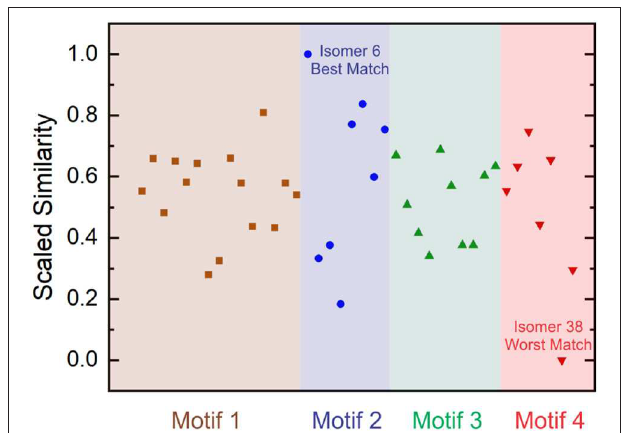
FIGURE 6 | Scaled Euclidean similarities of computed harmonic vibrational spectra to experimental IRMPD spectra for the protonated serine dimer. Isomer 6 gives the best match and Isomer 38 gives the worst match amongst the 40-isomer set. Isomers are ordered in increasing energy from left to right in each motif.